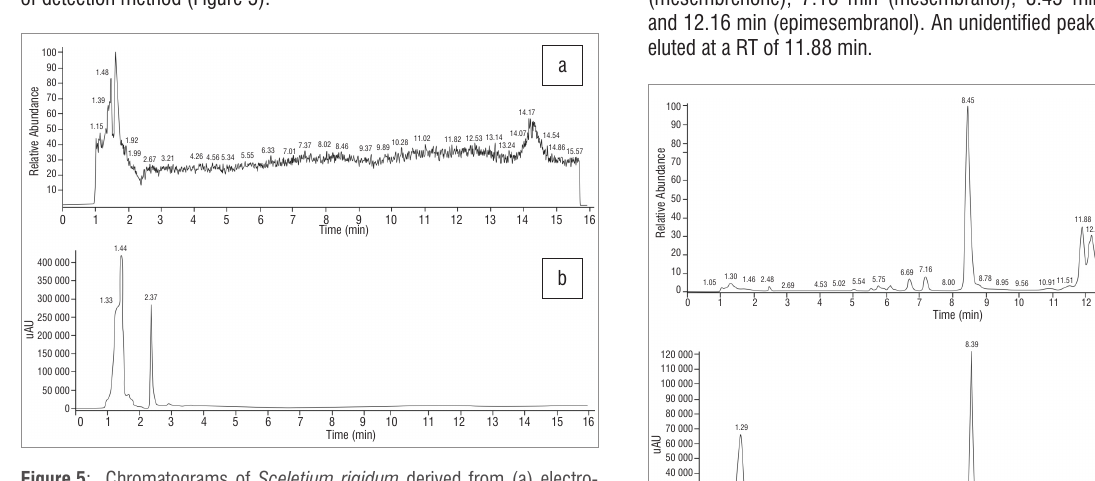
Figure 5 : Chromatograms of Sceletium rigidum derived from (a) electro- spray ionisation mass spectroscopy and (b) high-performance liquid chromatography with UV.